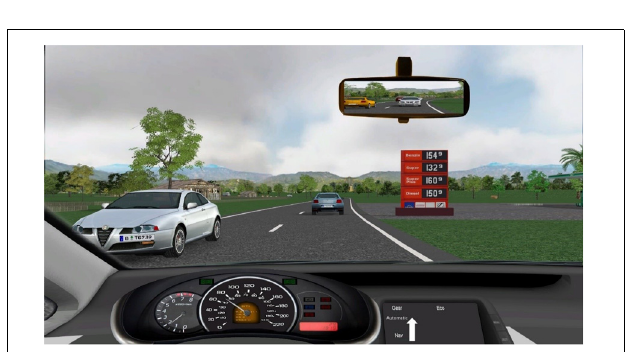
FIGURE 4 | Screenshot out of the cockpit with visually displayed memory